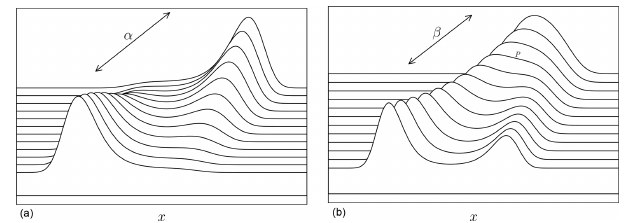
Figure 5. (a) Distributions from the exponential family (Eq. 6) where the parameter β is kept at a fixed value and α is varied. The distribution transforms from unimodal (back), to bimodal (middle), to a different unimodal distribution (front). The bimodal states have a larger and a smaller mode, depending on the position within the bimodal regime. The relative strength between modes depends on σ . (b) Distributions from the exponential family (Eq. 6) where the parameter α is kept at a fixed value and β is varied. A broad uni- modal state (at the back) splits into distinct bimodal states (to the front). In the middle a critical point exists, called the cusp (point P in Fig. 3), where the split